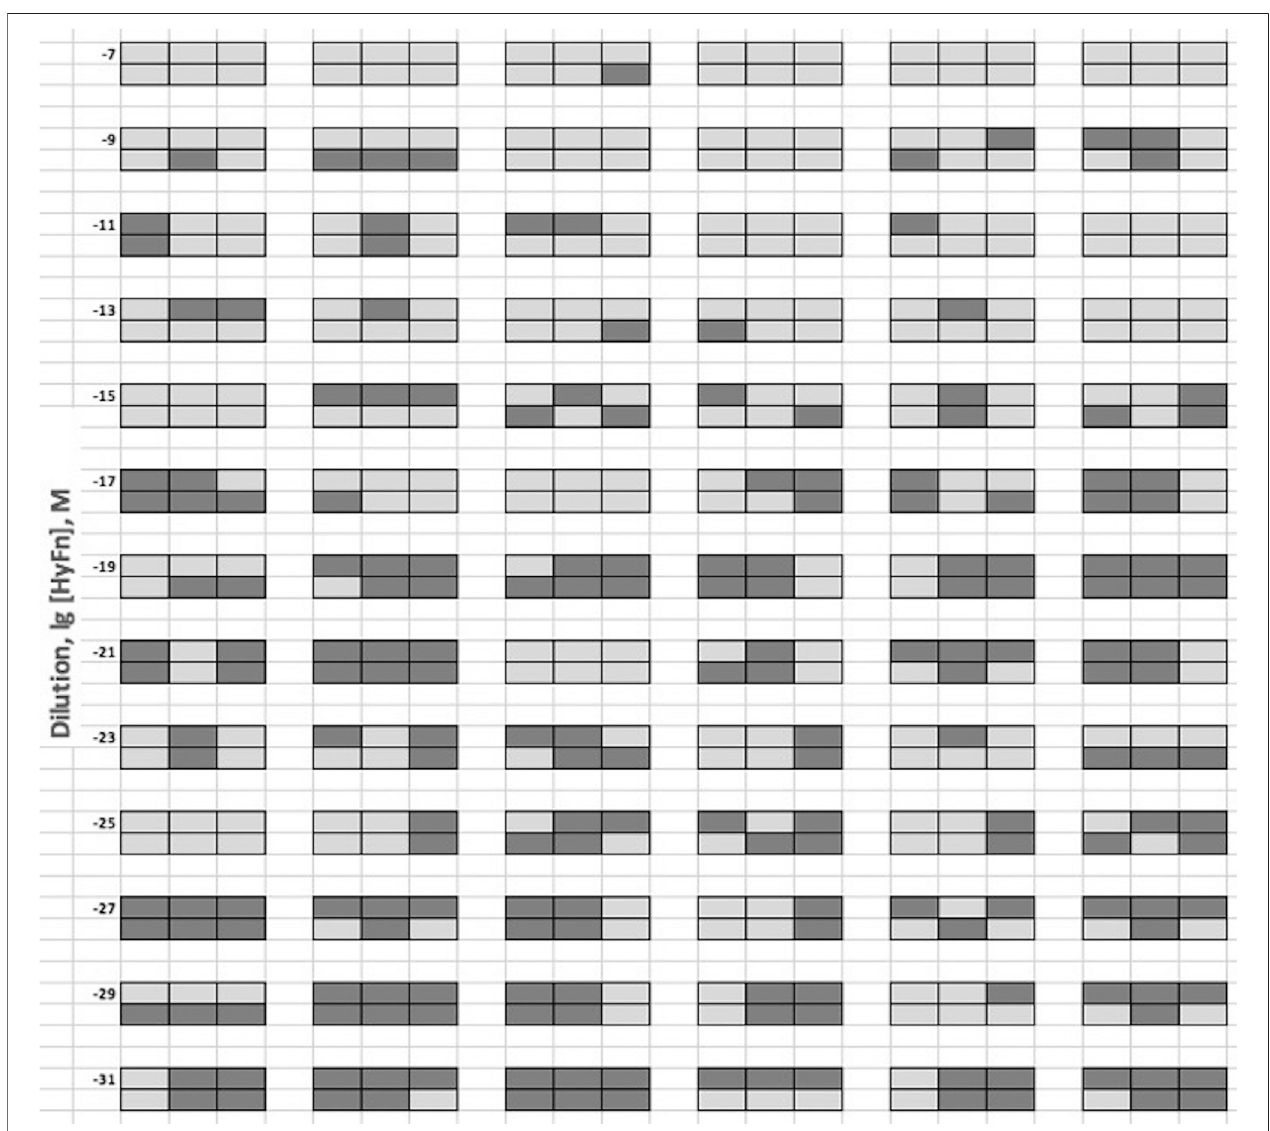
SCHEME1| Chartofglassslideswithsixdrieddropsoneachofthem.DilutionsofHyFnareindicatedontheleft.Sixslidesareshownforeachdilution.Paleboxes symbolize homogenous distribution of microspheres in a drop, dark boxes symbolize heterogenous distribution of microspheres.